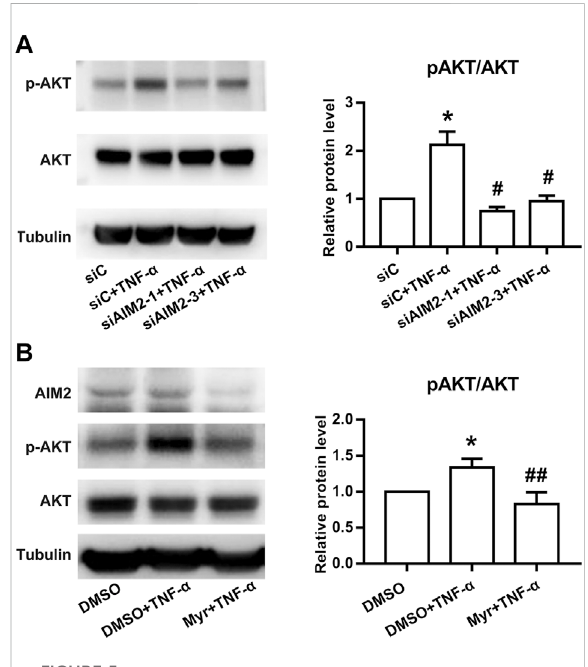
FIGURE 5 Effect ofMyrtreatmentorAIM2knockdownon theactivation of the AKT pathway in RA FLSs. Protein expression was detected using Western blot analysis. (A) RA FLSs were transfected with siRNAsforAIM2(siAMI2-1,siAIM2-3)orcontrolsiRNA(siC)for 72 h and then stimulated with TNF- α (10 ng/ml) for 30 min (B) RA FLSs were treated with Myr (400 μ M) or DMSO for 24 h, and then stimulated with TNF- α (10 ng/ml) for 30 min. Data (A,B) show the mean ± SD from at least 3 independent experiments. * p < 0.05 versus siC or DMSO, # p < 0.05, ## p < 0.01 versus siC + TNF- α or DMSO + TNF- α